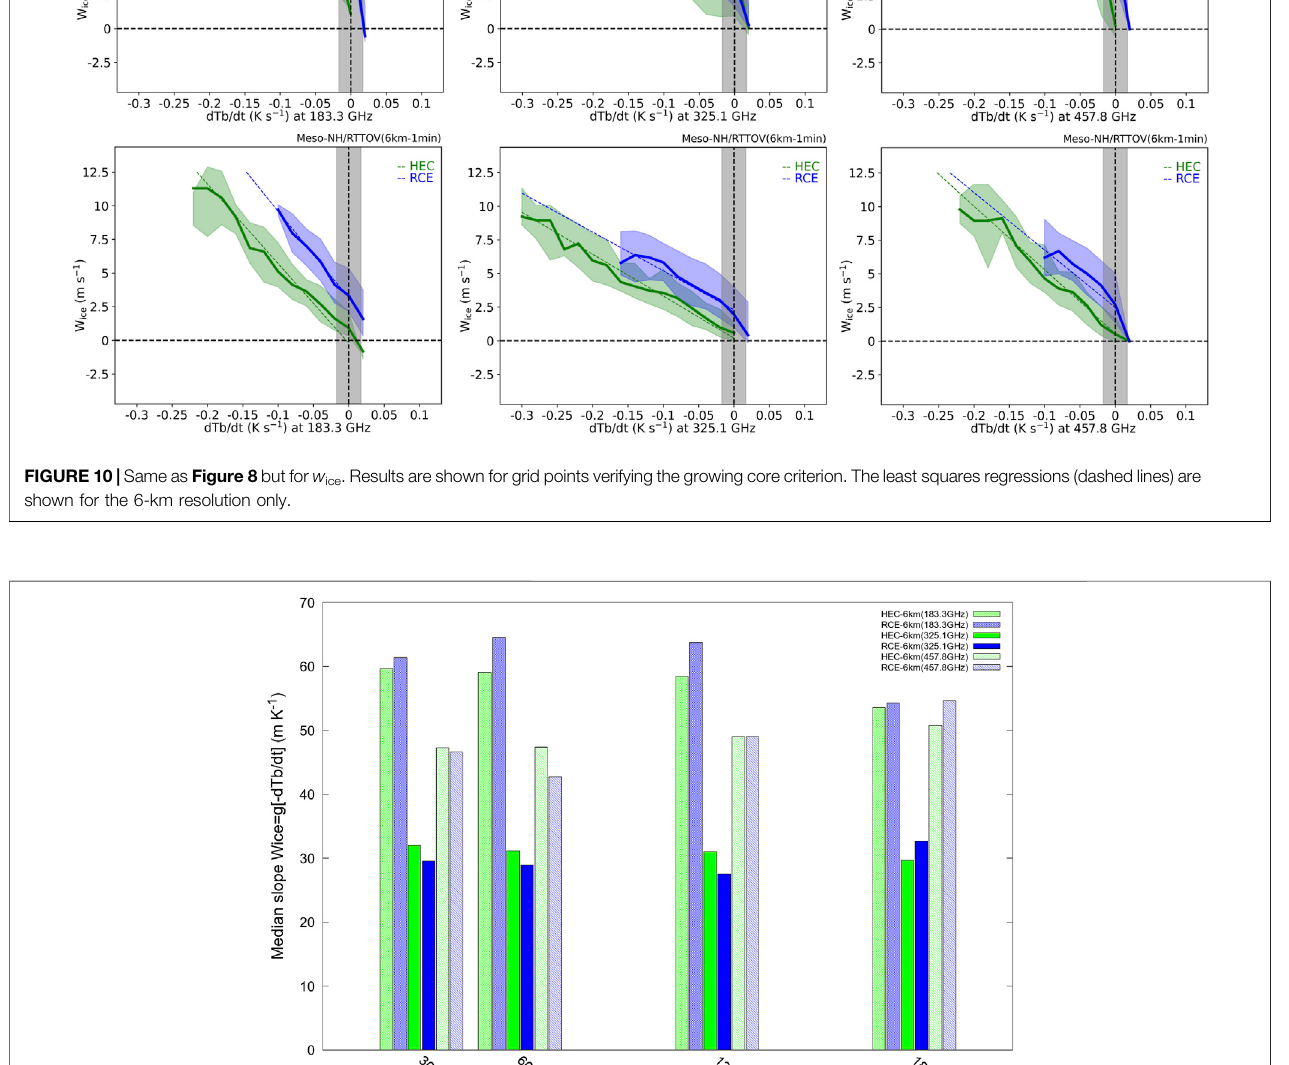
Frontiers in Remote Sensing |